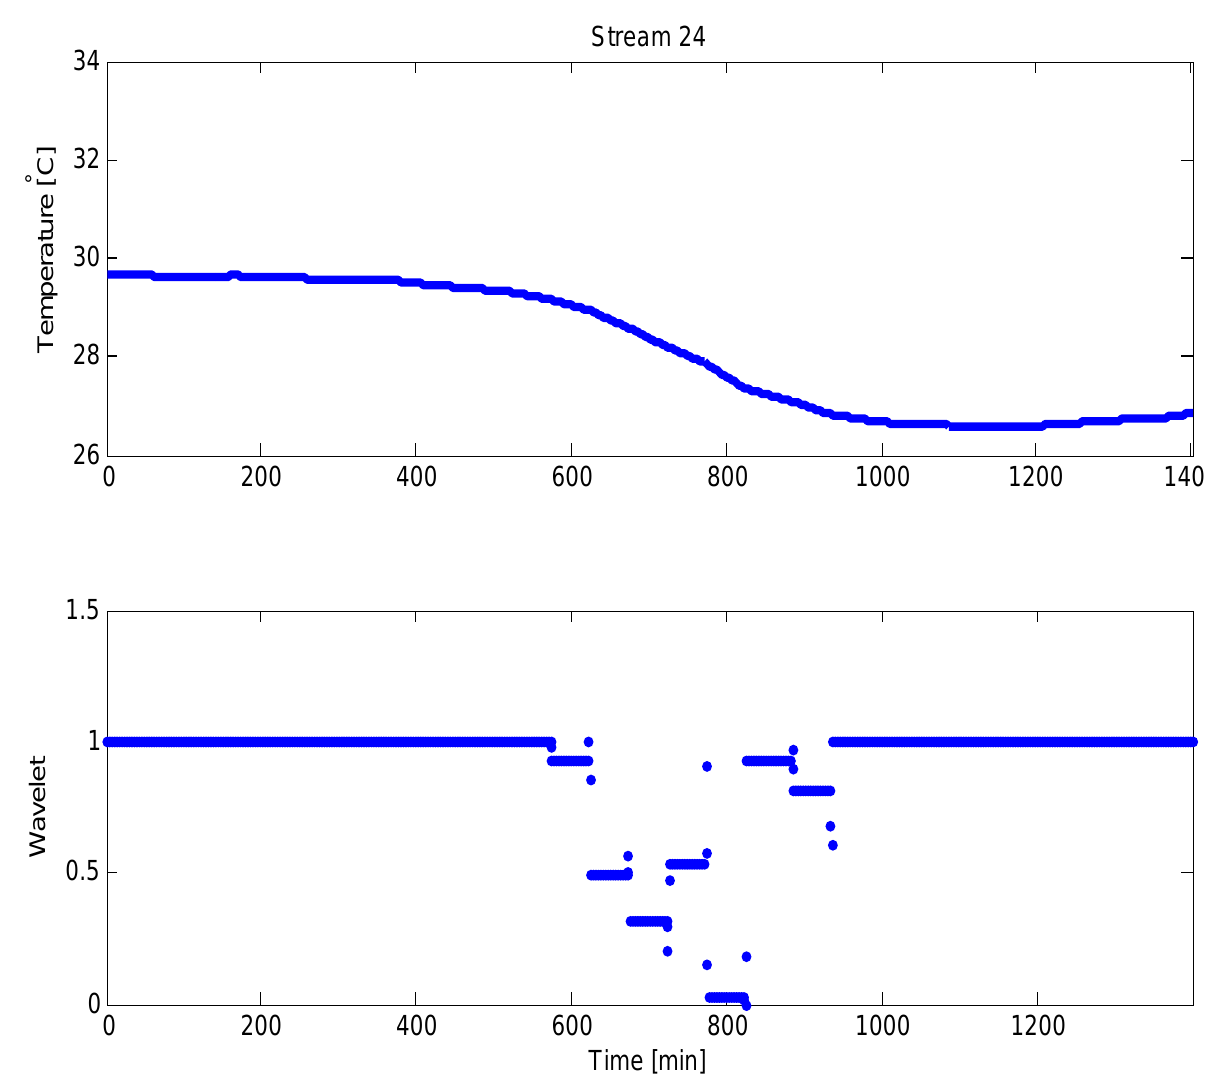
Figure 12. Depropanizer reflux drum case temperature experimental data and SSI results for the wavelet